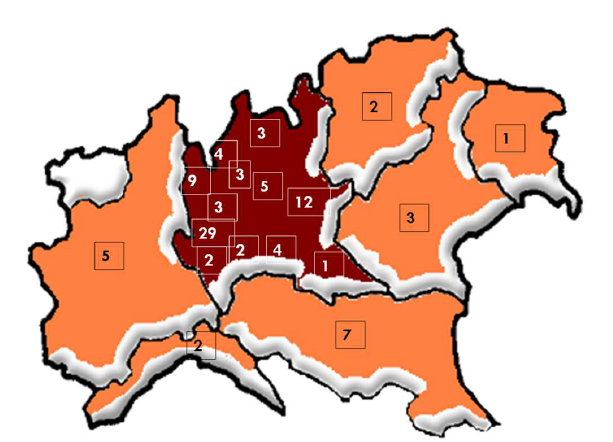
Figure 1: Geographical areas of origin of those